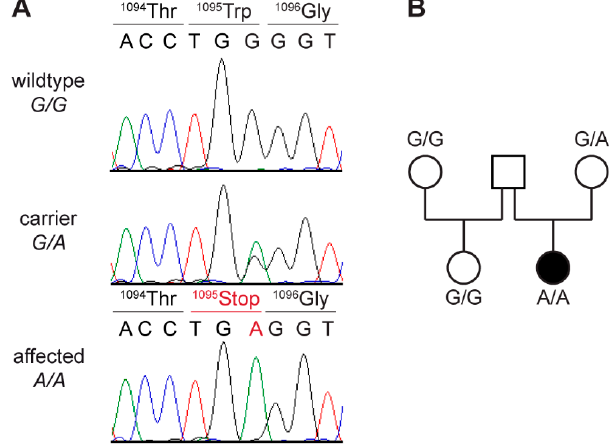
Figure 3. Details of the LAMA2 :c.3285G>A variant. ( A ) Representative Sanger sequencing elec- tropherograms of dogs with three different genotypes are shown. Amino acid translations are indicated. ( B ) Pedigree of affected Italian Greyhound. Genotypes at LAMA2 :c.3285G>A variant are indicated. No sample of sire was available for genotyping. Dam was confirmed to be heterozygous, as expected for an obligate carrier of a monogenic autosomal recessive trait.